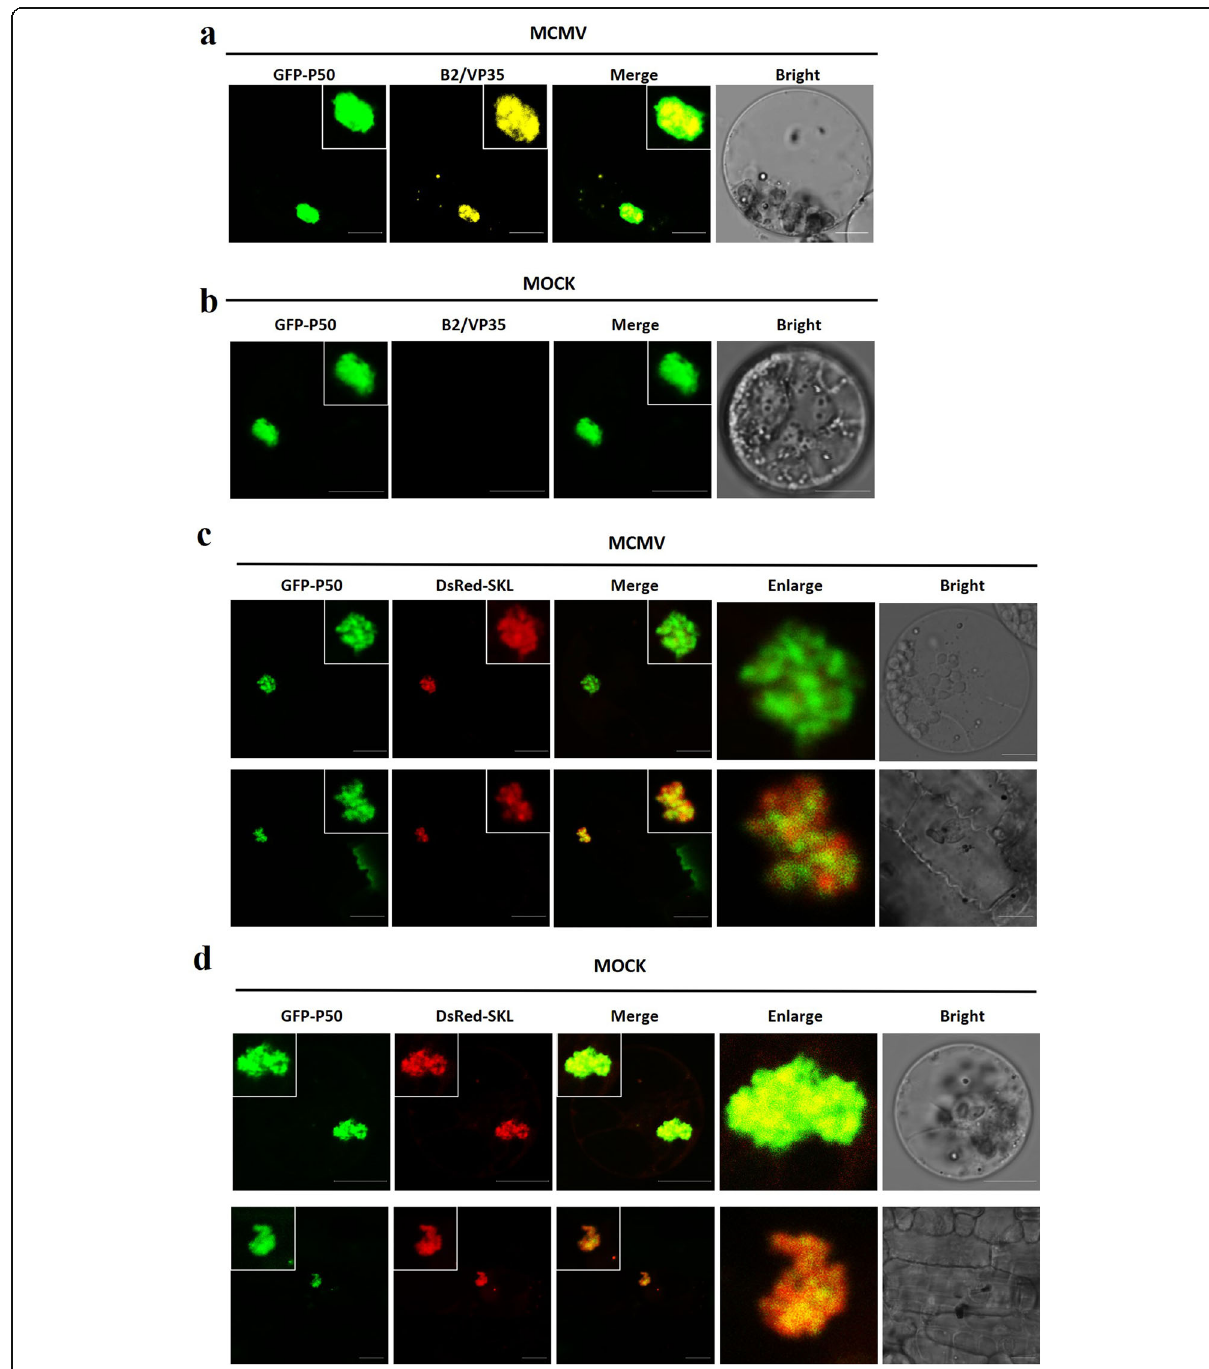
Fig. 3 Aggregated peroxisomes serve as the replication sites of maize chlorotic mottle virus (MCMV). a , b Co-localization of dsRNA with the MCMV auxiliary replication protein P50 (GFP-P50) in the presence ( a ) or absence ( b ) of MCMV at 3 days post-transfection (dpt). Bars, 10 μ m. c , d Co-localization of MCMV auxiliary replication protein P50 (GFP-P50) with aggregated peroxisomes in the presence ( c ) or absence ( d ) of MCMV. The green/red fluorescence was observed at 24 h post-transfection (hpt) (protoplasts) and 36 hpb (leaves), respectively. Bars, 10 μ